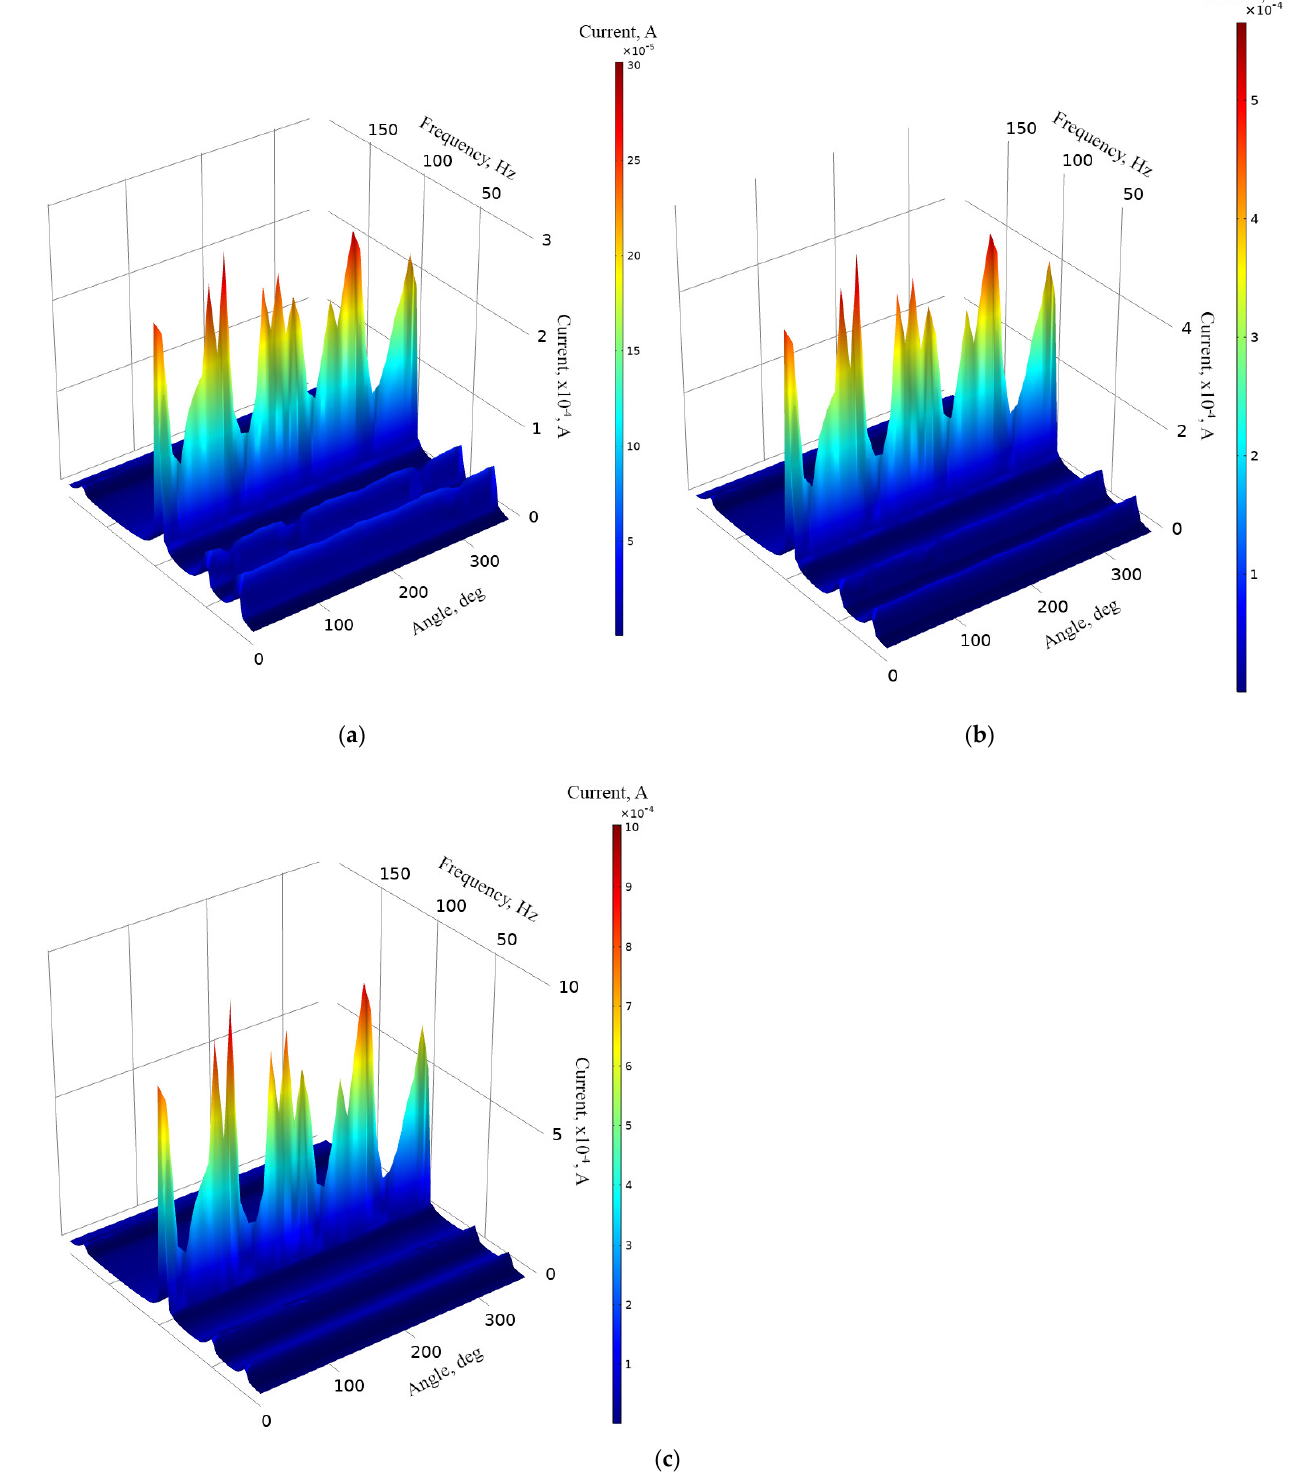
Figure 8. Frequency—current—angle of excitation motion characteristics of the energy harvester with different loads; ( a )—load equal to 1 MΩ; ( b )—load equal to 500 kΩ; ( c )—load equal to 250 kΩ.